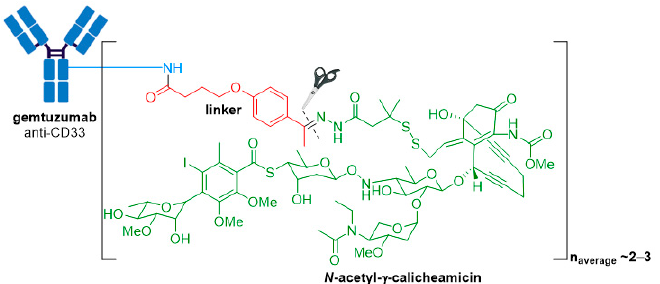
Figure 4. Structure for Mylotarg ® (gemtuzumab ozogamicin). The antibody is shown in blue, and chemical structures for linker and payload are in red and green, respectively. The cleavage site is indicated by scissors.